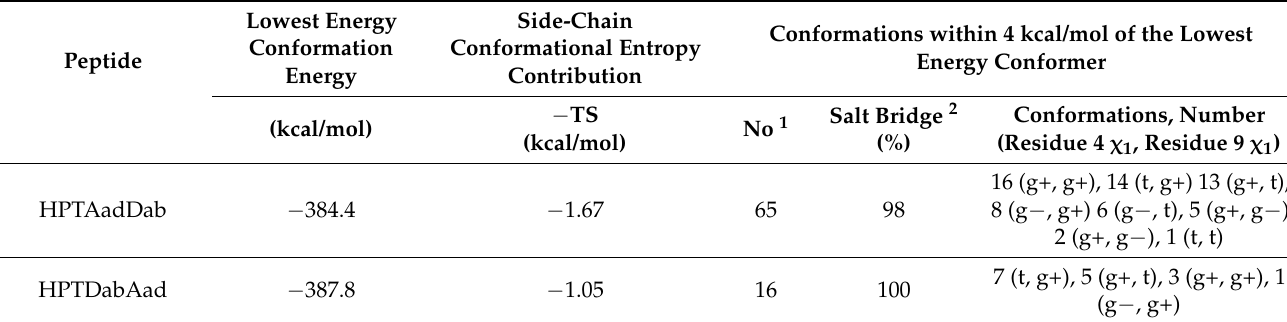
Table 4. Summary of the low-energy conformations from the side-chain conformational analysis of peptides HPTAadDab and HPTDabAad by molecular mechanics